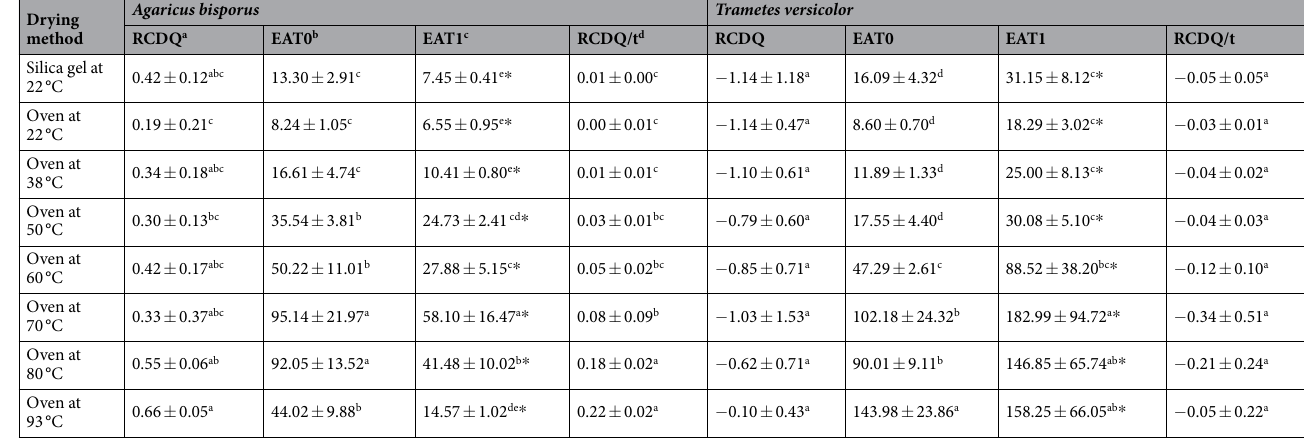
Table 5. Efficacy of drying methods estimated based on the amount of dsDNA extracted divided by the time (in hours) that each method took to dry the mushrooms. The means in each column followed by the same superscripts are not significantly different and the “ * ” marks in each row within the same specimen indicate significant differences between EAT0 and EAT1 at P < 0.05 according to Duncan’s multiple range tests. a RCDQ, Relative change of dsDNA quantity over one month storage. b EAT0, Efficacy of drying based on dsDNA quantity per unit time of drying, extracted immediately after drying. c EAT1, Efficacy of drying based on dsDNA quantity per unit time of drying, extracted one month after drying. d RCDQ/t, Efficacy of drying on the relative change of dsDNA quantity over one month of